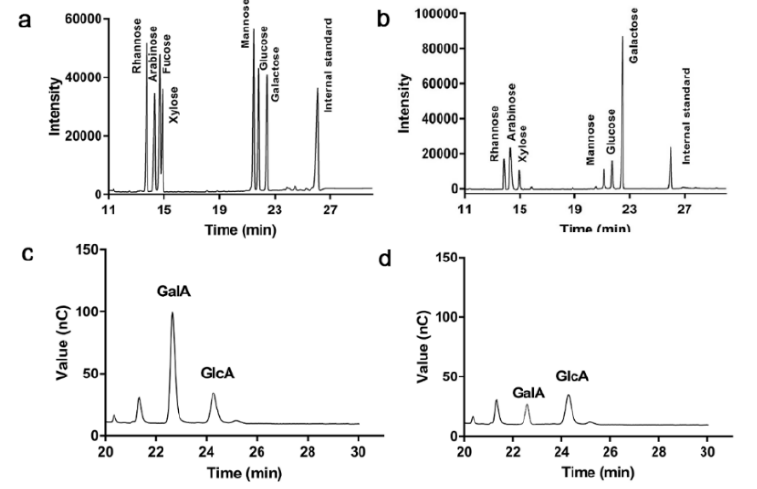
Figure 2. GC of standard monosaccharides ( a ) and Pan ( b ); IC of uronic acid standard ( c ) and Pan ( d ).